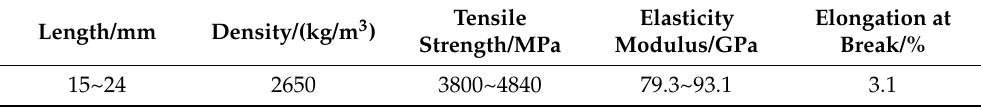
Table 3. Physical properties of basalt